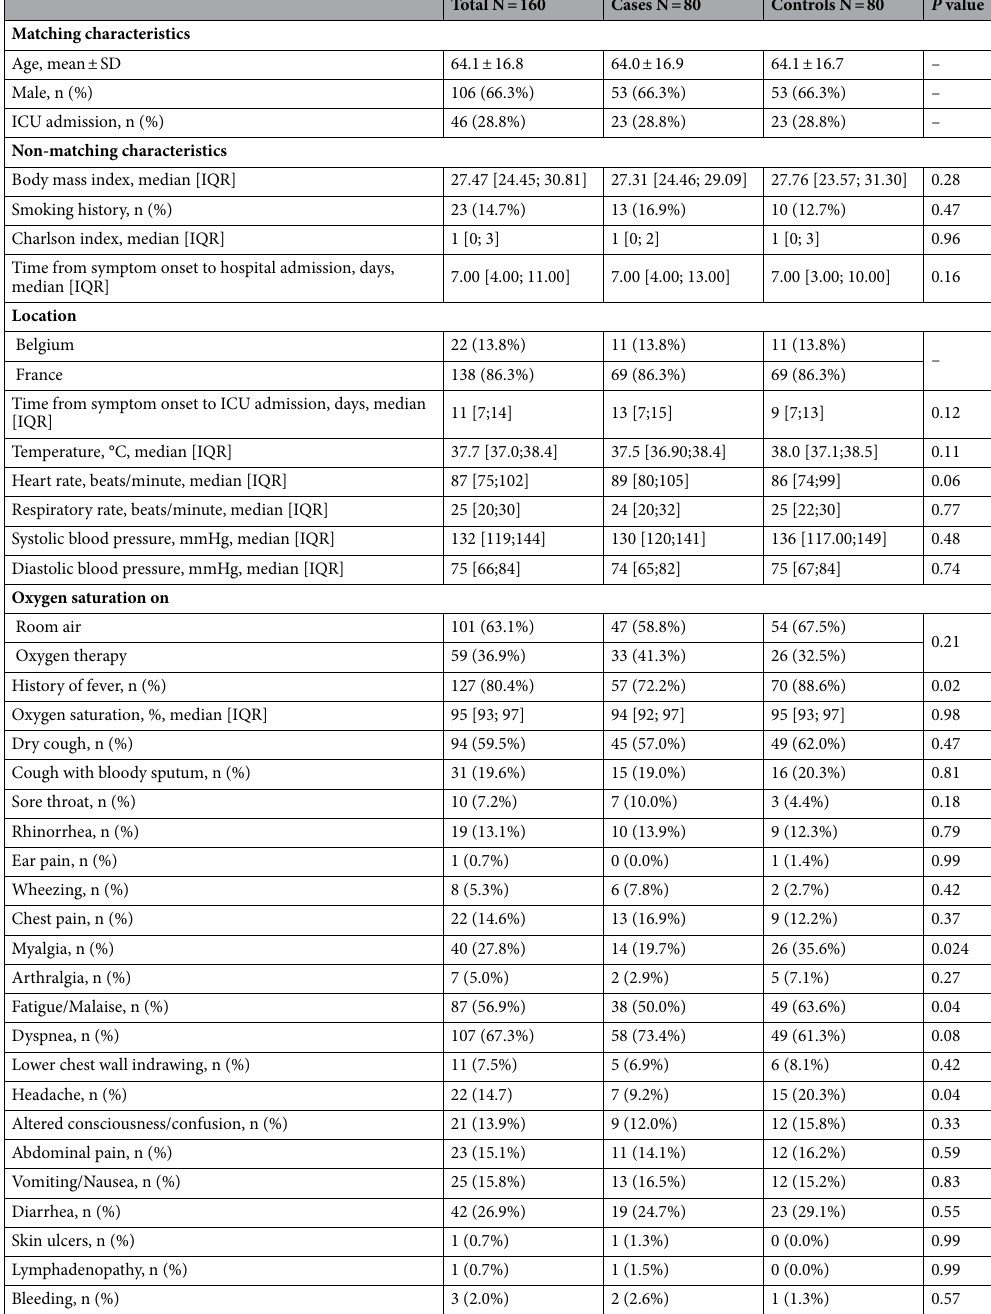
Table 1. Baseline characteristics of study population. ICU intensive care unit, IQR interquartile